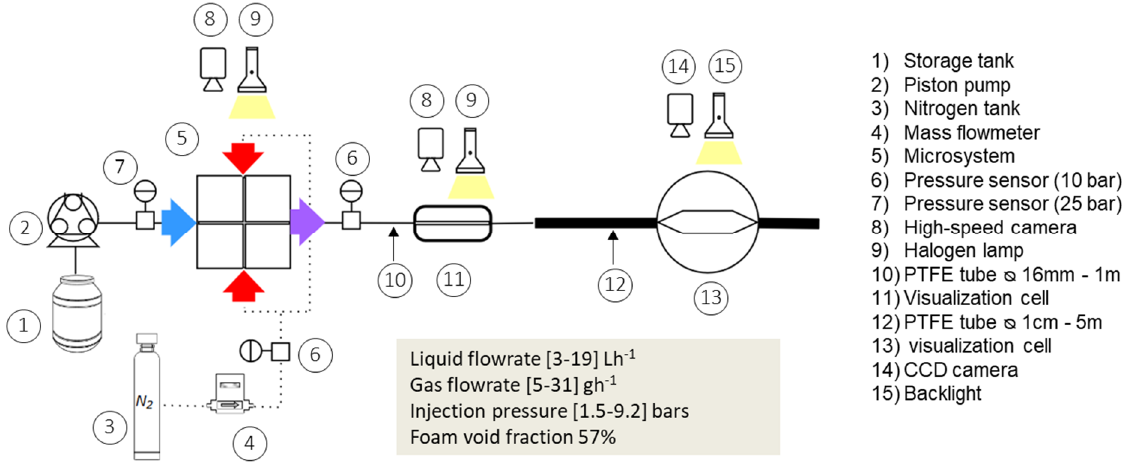
Figure 1. Schematic representation of the experimental processing